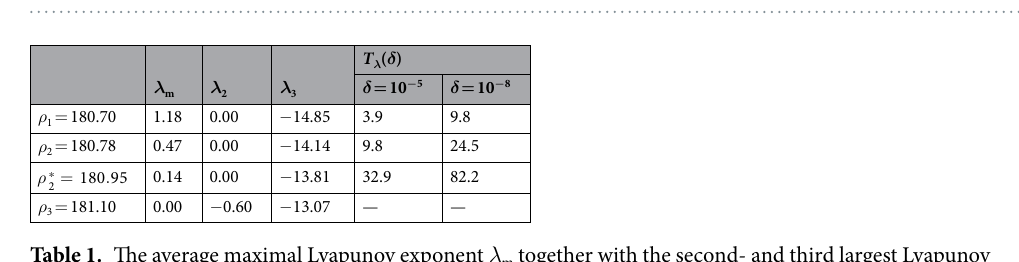
Figure 1. Strong chaos (red, for ρ < ρ p ≈ 180.72), partially predictable chaos (green, for ρ p < ρ < ρ C ≈ 180.96) and regular flow (blue, for ρ C < ρ ), for the Lorenz system (1). Shown are (from top to bottom), z n from the Poincaré section x = 15 (for a window of z n ), the maximal Lyapunov exponent λ m , the cross-distance scaling exponent ν , see Eq. (2), and the cross-correlation C 12 ( t = 200), as defined by Eq. (3). PD1 and PD2 denote examples of period doubling bifurcations and SSB a bifurcation spontaneously breaking the symmetry ( x , y , z ) ↔ ( − x , − y , z ) of (1).